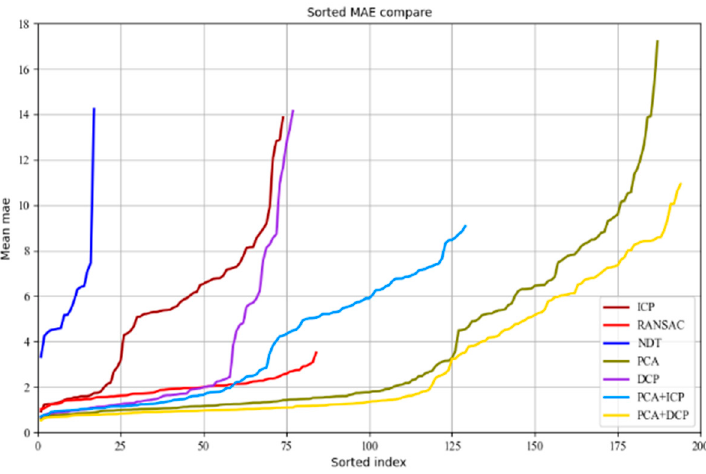
Figure 8. Sorted MAE comparison. Figure 9 is a comparison of different methods on a specific pair of real-world